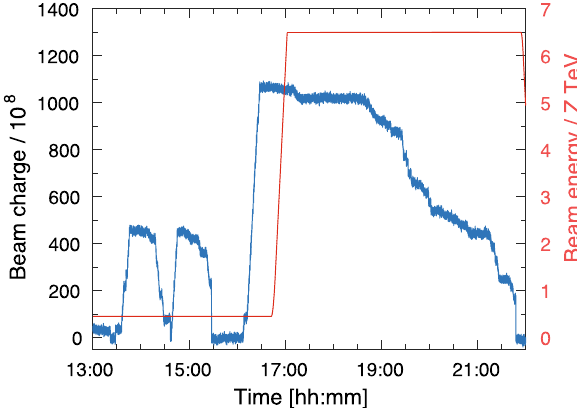
sistsinvaryingitsangularorientation.Theonsetofchan- nelingisidentifiedasadropofthelocallossesthatoccurs